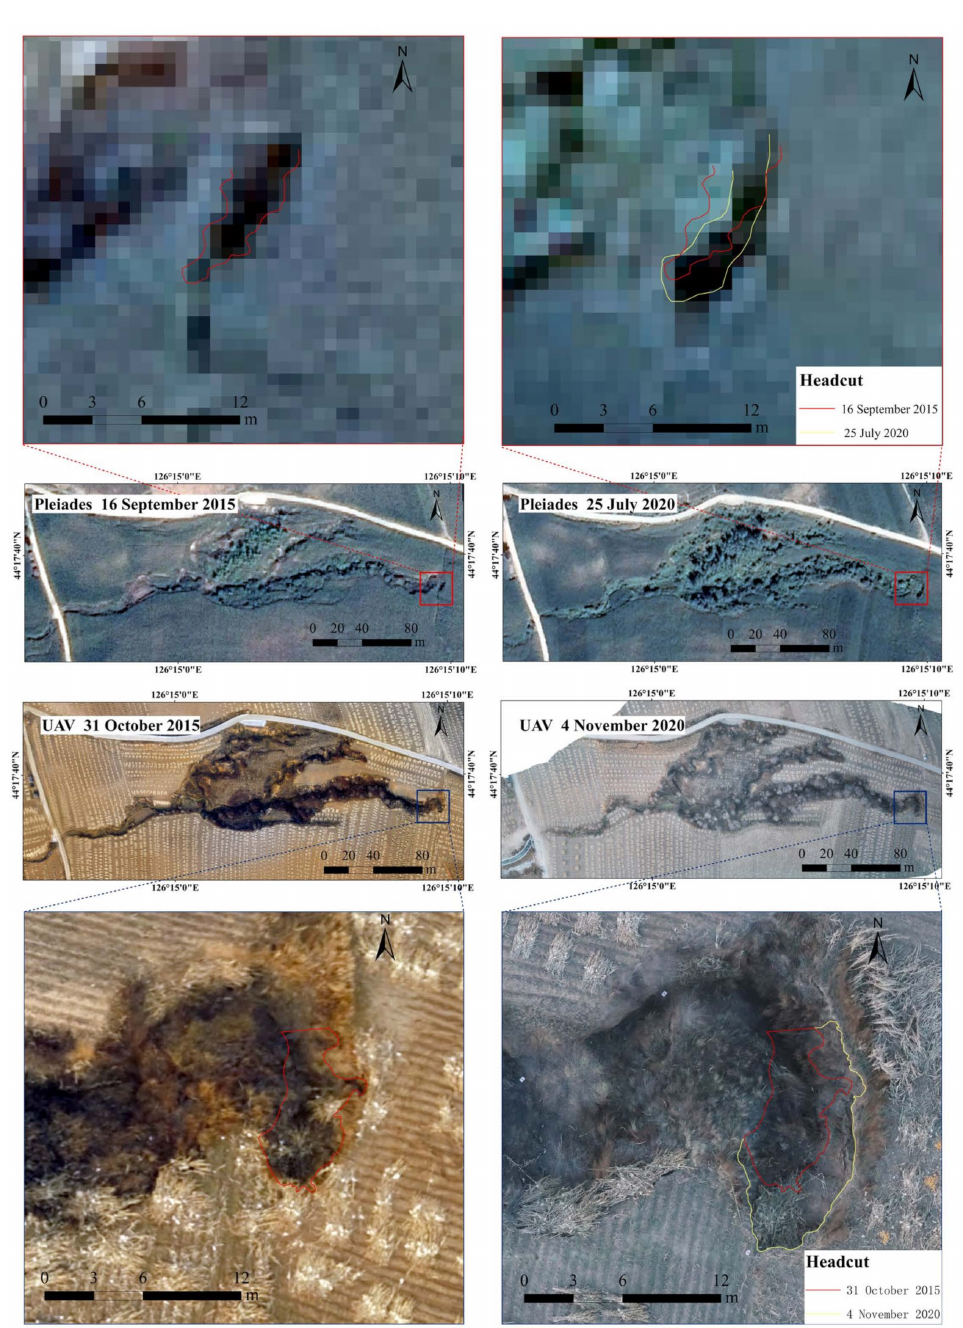
Figure 13. Comparison of high-resolution satellite (Pleiades) and UAV images for monitoring the gully headcut retreat between 2015 and